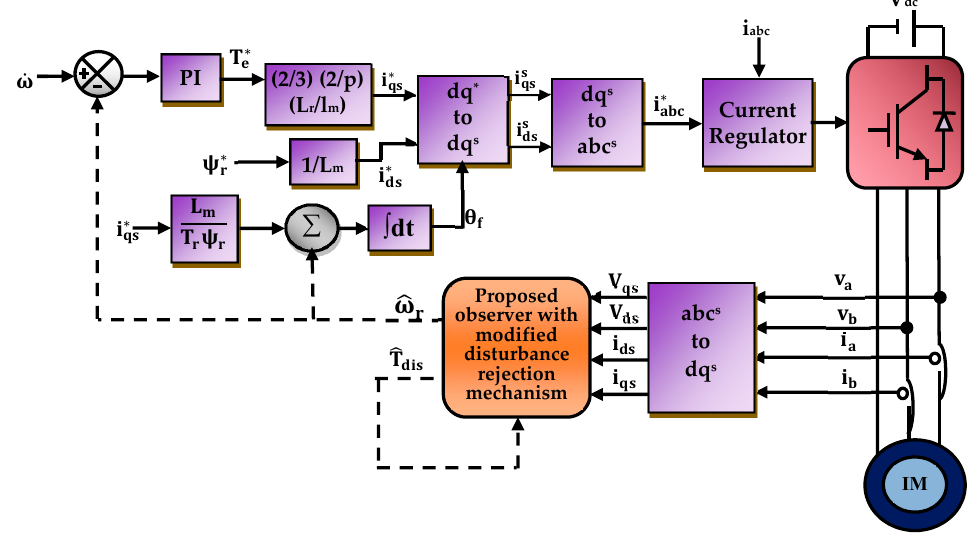
Figure 5. Voltage source inverter (VSI) fed speed sensorless induction motor drive system.